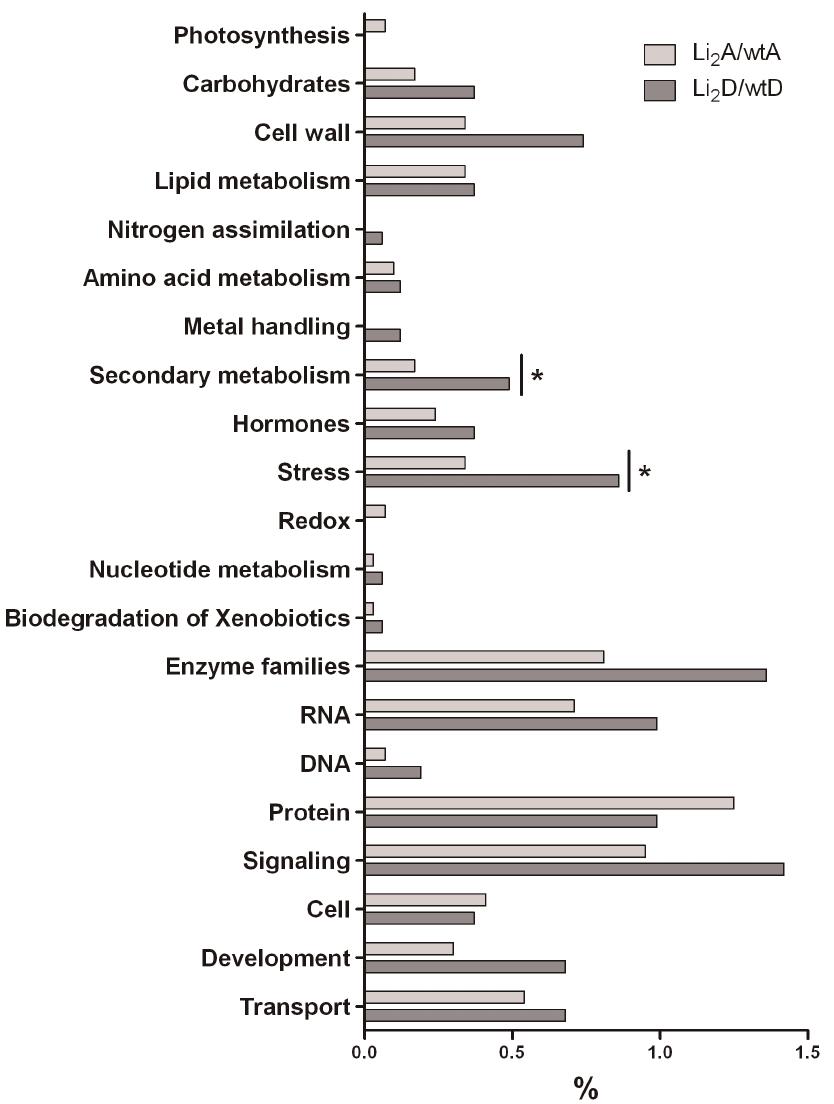
Figure 4. Mutation effects on functional distribution of homeolog genes during fiber elongation. Relative gene frequencies in functional categories were represented in percents from amount of biased genes in each subgenome. Asterisks indicate significant ( p -value , 0.05; Fisher’s exact test) enrichment of functional category between subgenomes with genes that changed expression in result of mutation. Table S2 in File S1 provides Fisher’s exact test results. MapMan BIN structure was used for functional categorization of genes regulated by Li 2 mutation. Only functional categories with more than 0.06% gene representation are shown here. Carbohydrates combine 6 BIN classes, including major and minor carbohydrates, glycolysis, fermentation, gluconeogenesis and oxidative pentose phosphate